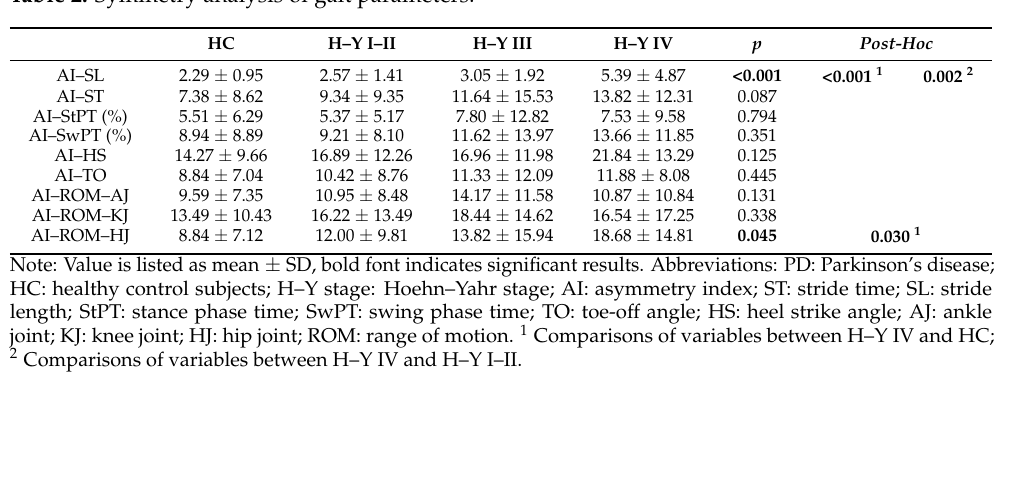
Table 2. Symmetry analysis of gait